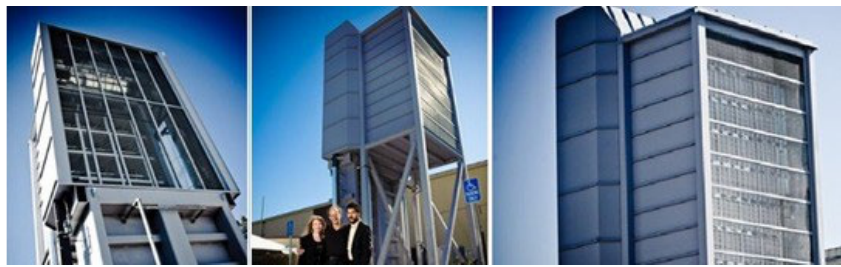
Figure 16. Global Thermostat plant [3].